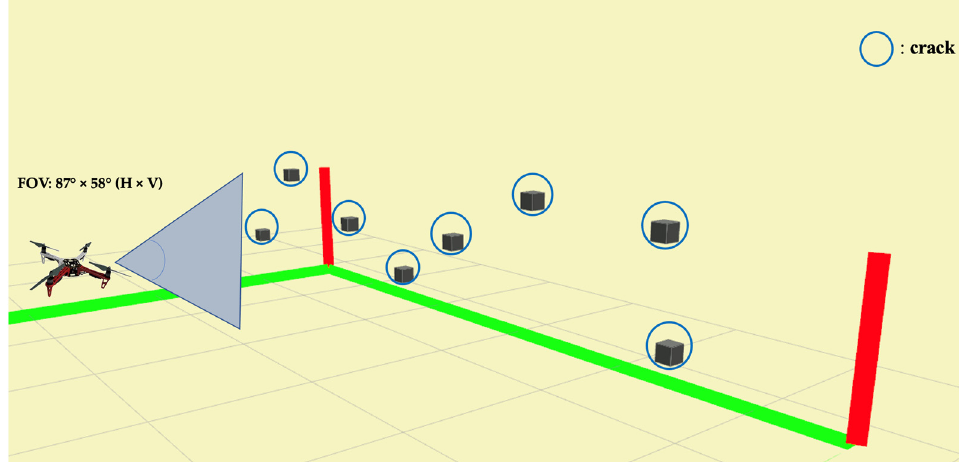
Figure 8. The field of view (FOV) of the inspection window.